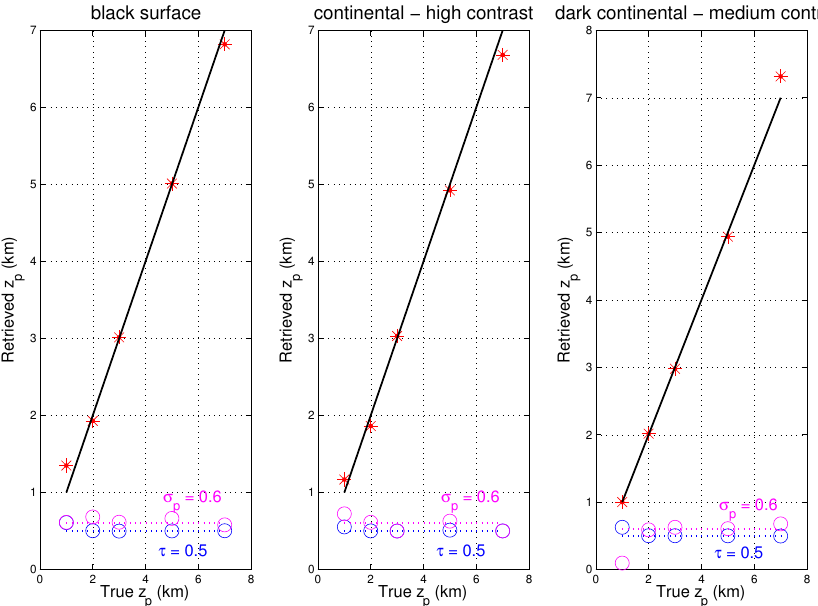
Fig. 6. Synthetic retrievals of the peak height of a lognormal aerosol vertical profile z p (red asterisks), aerosol optical thickness τ aerosol (blue circles) and peak width σ p (magenta circles), for varying z p and fixed parameters τ aerosol =0.5 (blue dashed line) and σ p =0.6 (magenta dashed line). The black line is the 1:1 line. A coarse urban absorbing aerosol (IA3) has been used. The viewing geometry is statistically repre- sentative for SCIAMACHY observations over Kanpur with SZA=43 ◦ , LZA=11 ◦ , Azimuth=149 ◦ . Left panel: black surface, ρ A = ρ B =0, middle panel: land surface having high contrast, ρ A =0.22, ρ B =0.03, right panel: dark land surface having medium contrast, ρ A =0.13, ρ B